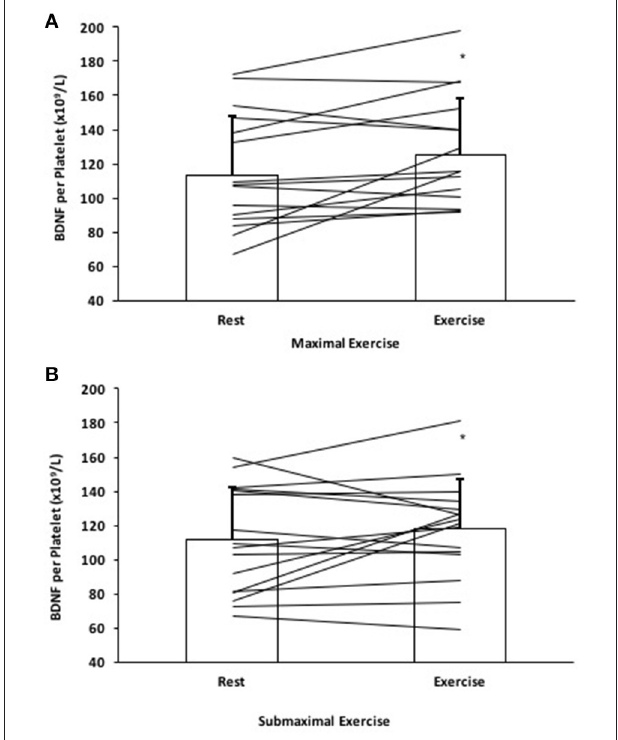
FIGURE 3 | BDNF per platelet response to (A) Maximal effort exercise and (B) Submaximal effort exercise. Individual responses denoted by straight lines and group means represented by bars. *Significantly different compared to rest, p <